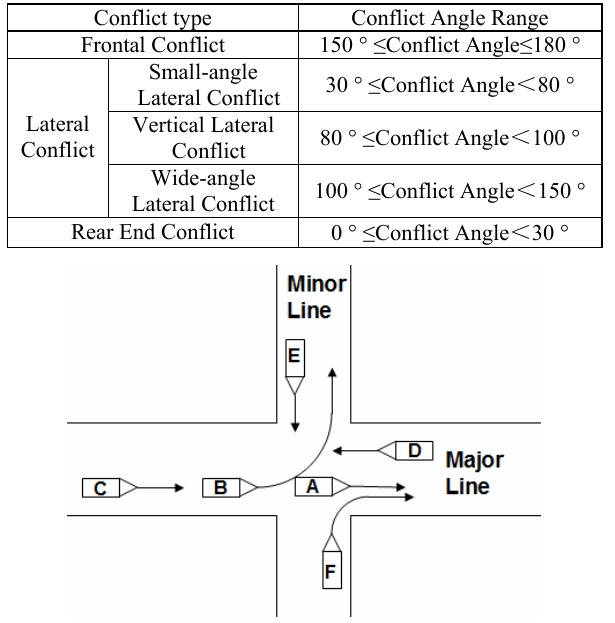
Table 1. Conflict Classified by Conflict Angle